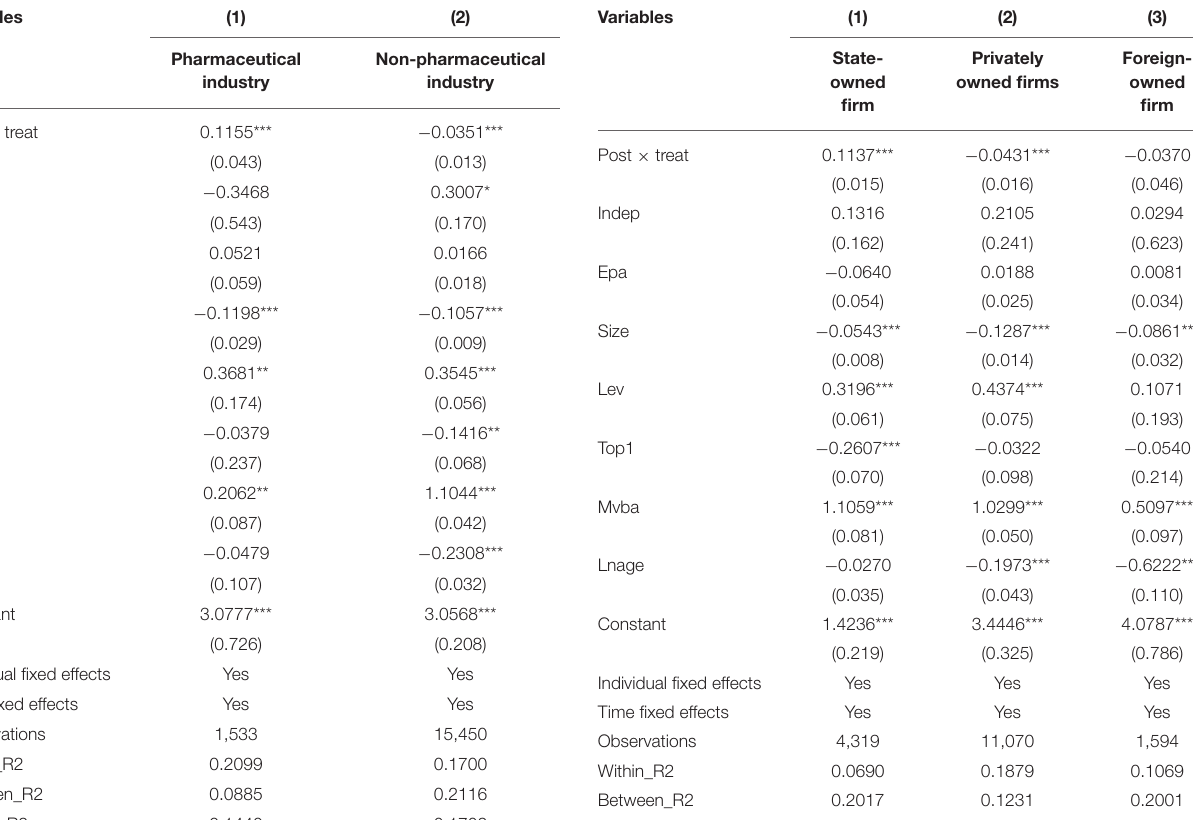
TABLE 6 | Ownership regression results (state-owned firm vs. privately owned firm vs. foreign-owned firm).